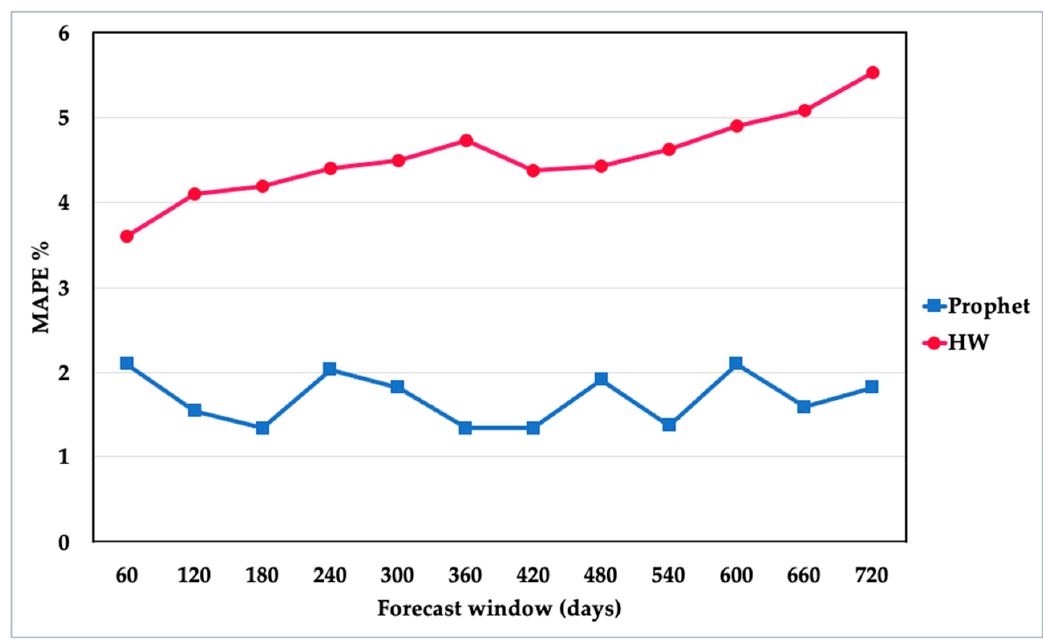
Figure 8. Smoothed mean absolute percentage errors for the Prophet and Holt–Winters models.